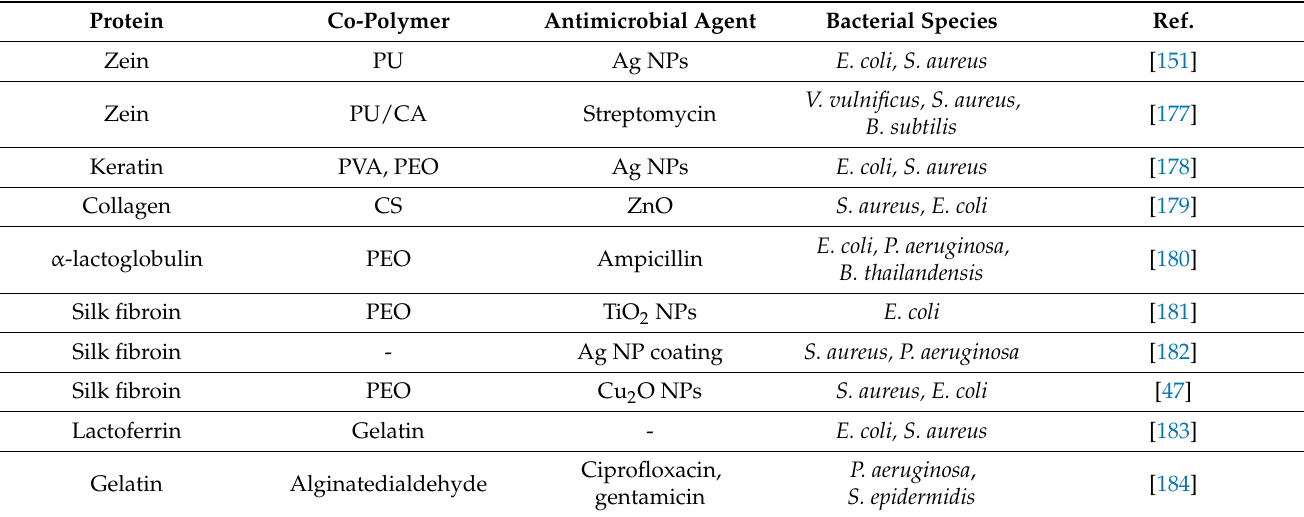
Table 5. Biofuntionalized antibacterial materials with